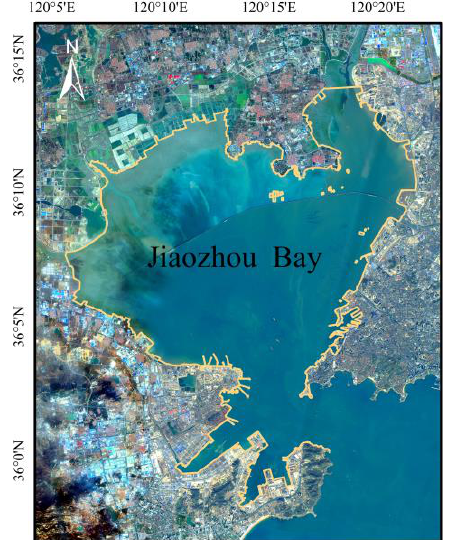
Figure 1 The study range and its coastline of Jiaozhou Bay